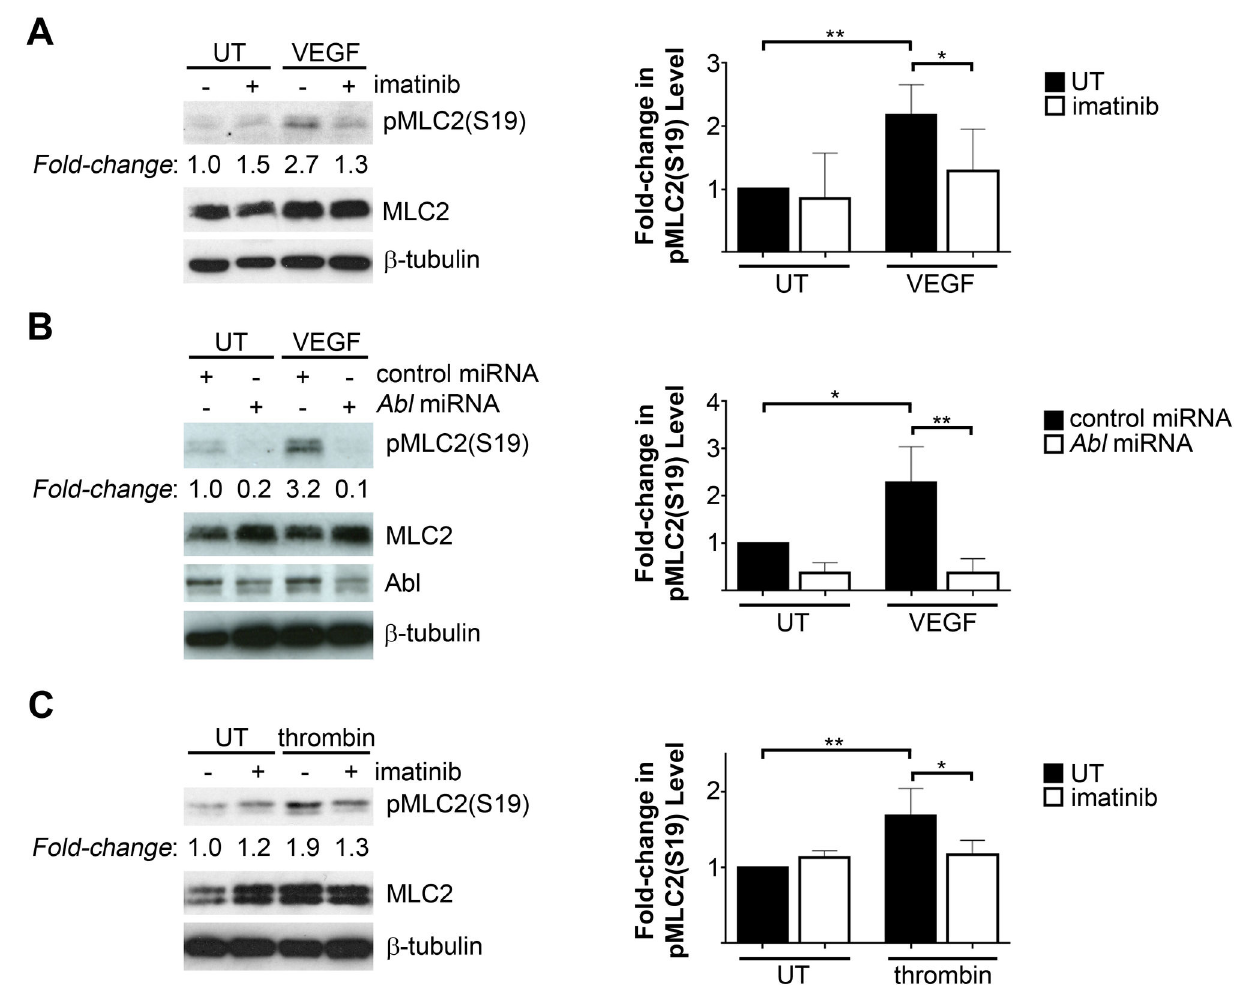
Figure 5. Loss of Abl kinase activity impaired MLC2 phosphorylation in response to endothelial permeability-inducing factors. ( A ) Assessment of phospho-MLC2 serine (S) 19 levels in HMVECs following VEGF stimulation (100ng/mL, 5 minutes) with or without imatinib pre-treatment (10μM). pMLC2(S19) levels, normalized to total MLC2, are quantified in the right panel, relative to levels in untreated cells (UT). Data are presented as means +/- SD (n=7). ( B ) Evaluation of pMLC2(S19) levels in HMVECs expressing either control or Abl miRNAs following VEGF treatment. pMLC2(S19) levels, normalized to total MLC2, are quantified in the right panel, relative to levels in untreated control miRNA-expressing cells (UT). Data are presented as means +/- SD (n=3). ( C ) Assessment of pMLC2(S19) levels in thrombin-treated HMVECs (1U/mL, 2 minutes), with or without imatinib pre-treatment. pMLC2(S19) levels, normalized to total MLC2, are quantified in the right panel, relative to levels in untreated cells (UT). Data are presented as means +/- SD (n=4). *P<0.05;